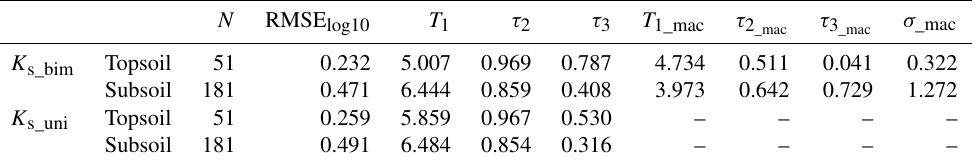
Table 6. Optimal tortuosity parameters of K s_uni and K s_bim .